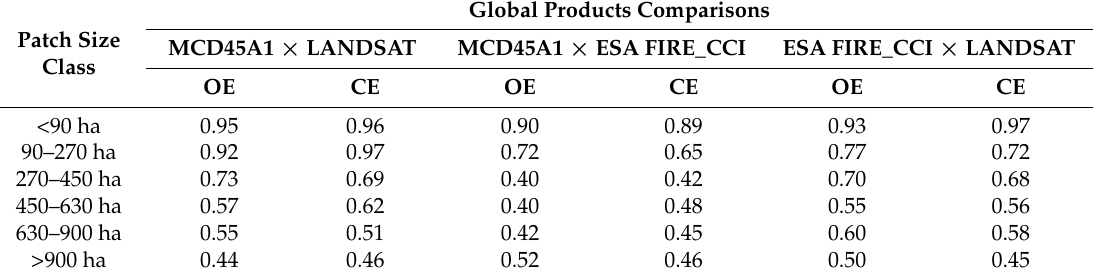
Table 4. Omission error (OE) and Commission error (CE) between pair-wised global remote